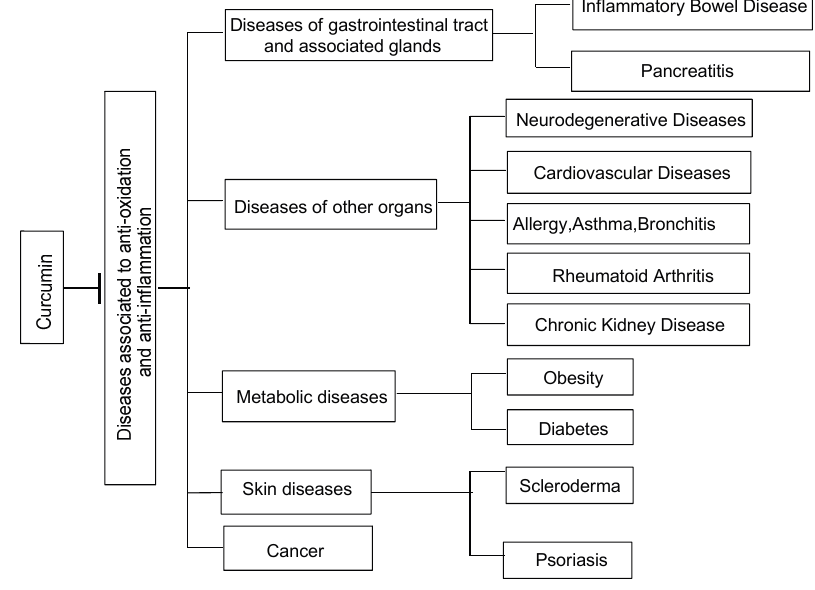
Figure 3. The main chronic diseases curcumin is active